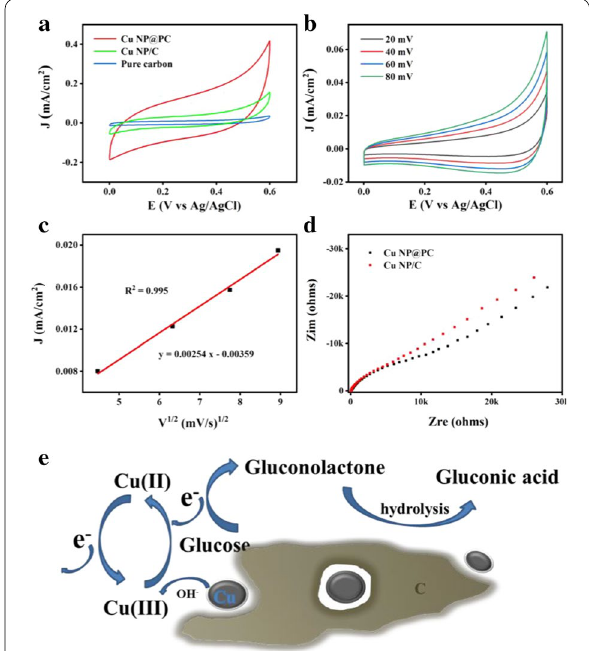
Fig. 4 a CV curves of Cu NP@PC, Cu NP/C and pure carbon sample for glucose oxidation reaction; (0.2 mM glucose, 0.1 M KOH, scan rate: 100 mV/s.) b CV curves of Cu NP@PC in 0.1 M KOH at different scan rates (20, 40, 60, 80 mV/s); c Plot of current density at 0.4 V in